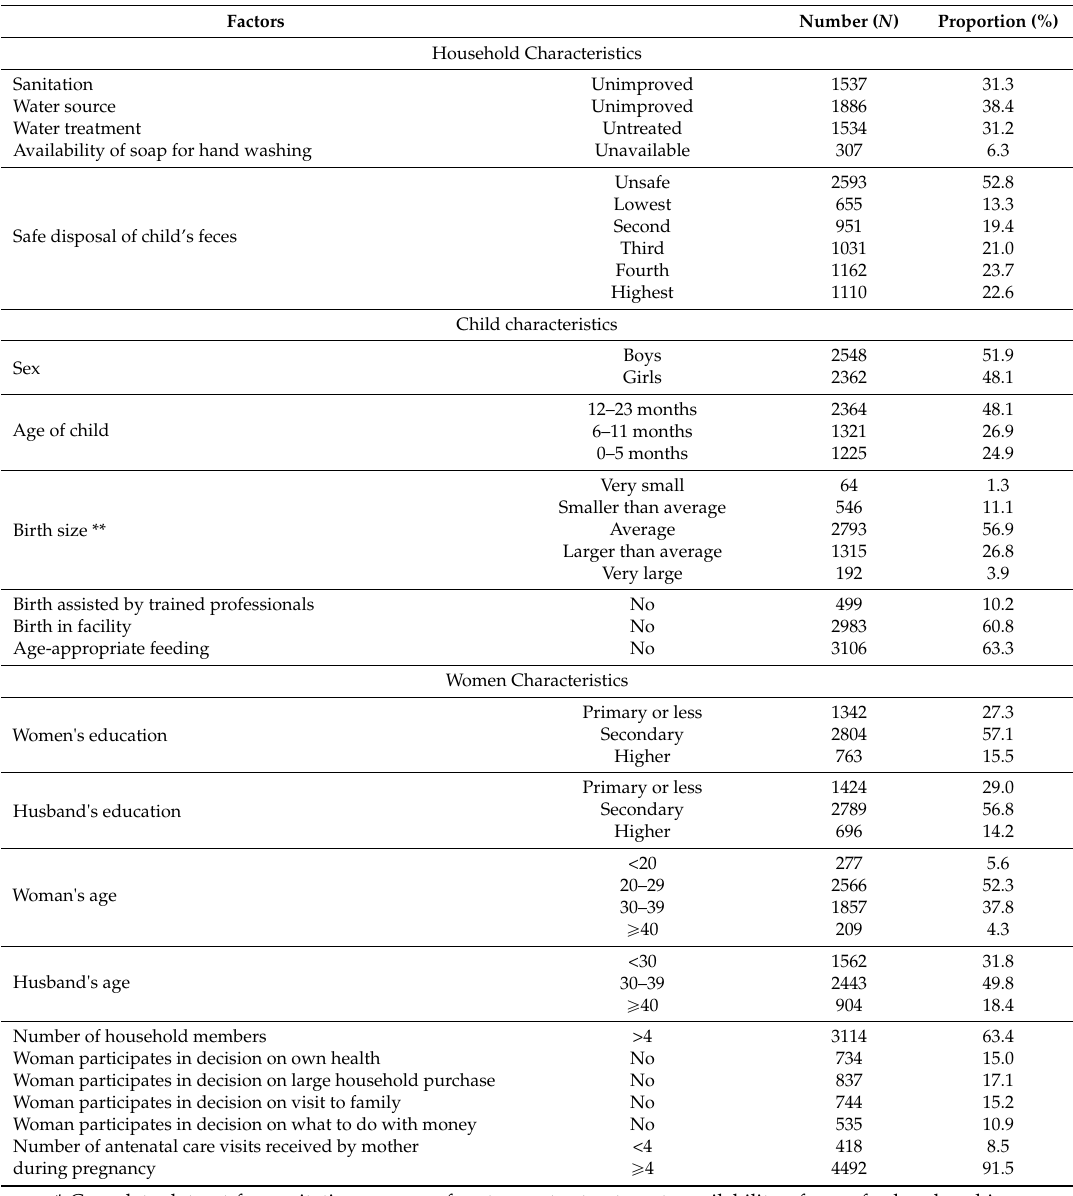
Table 1. Population characteristics * of children <24 months in the Indonesian Demographic Health Survey 2012 (N =